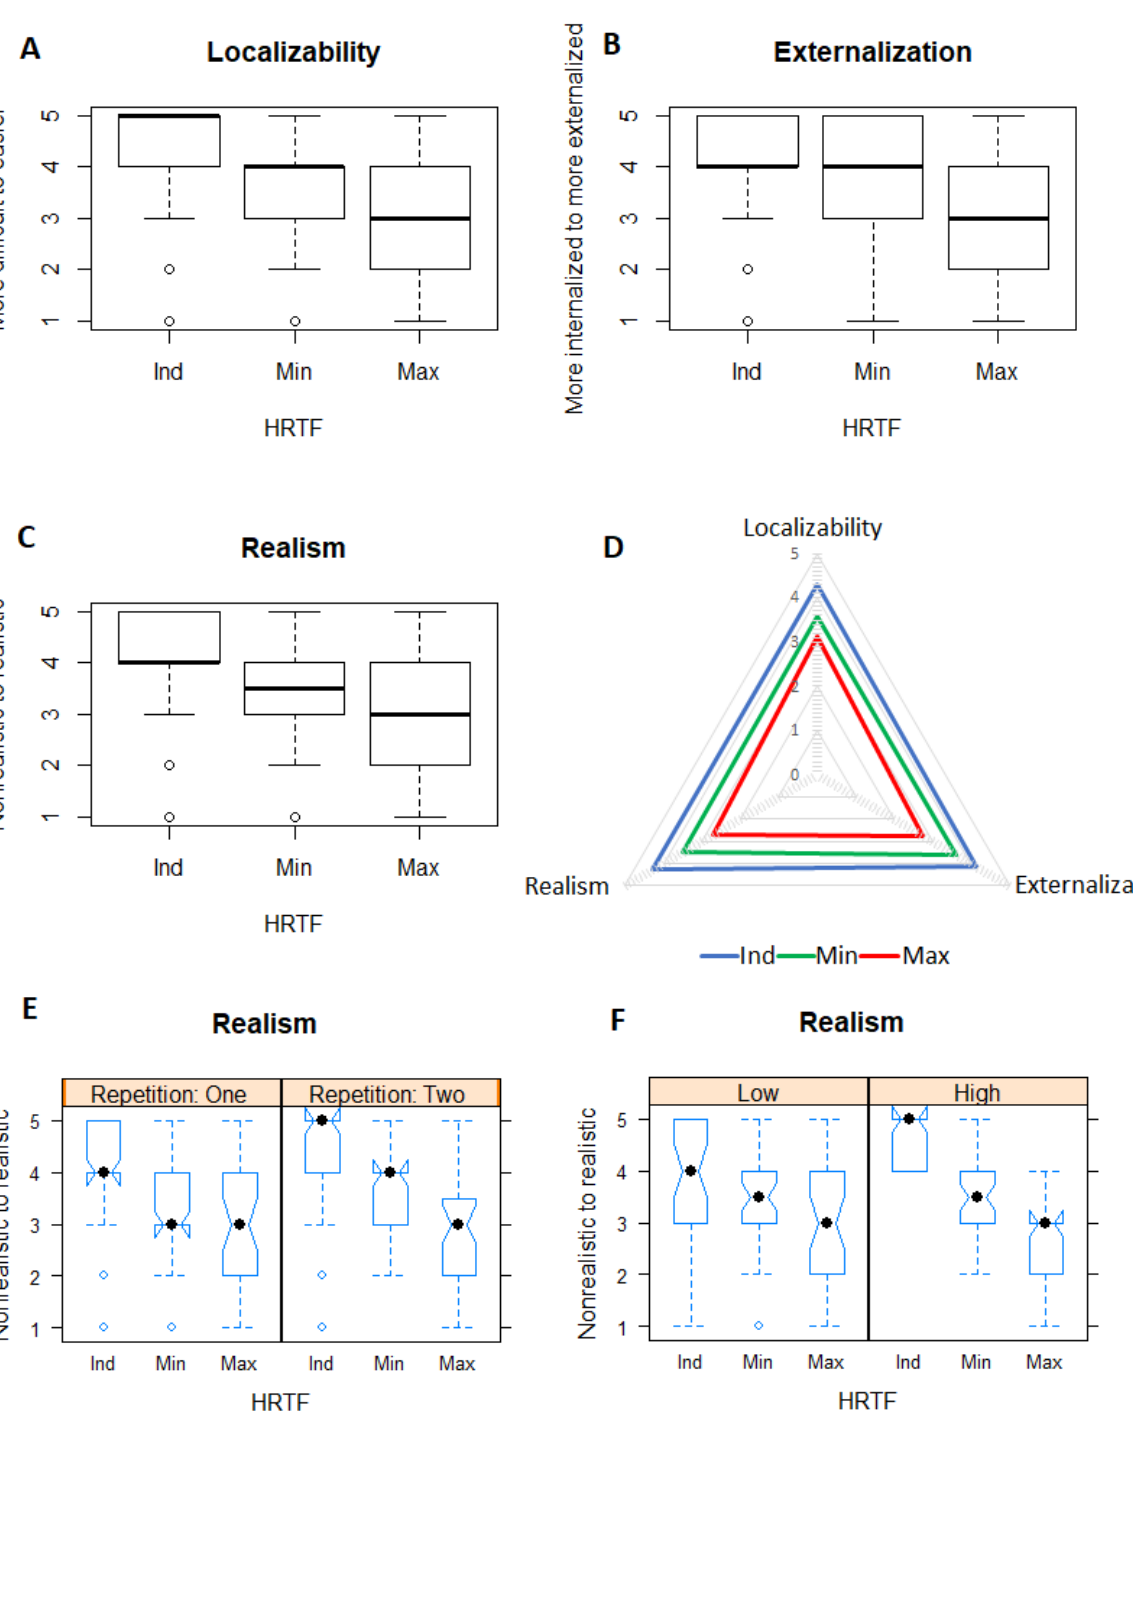
Figure 5. Result of the second test (individual vs minimal vs maximal). A: Localizability overall box plot; B: Externalization overall box plot; C: Realism overall box plot; D: Radar chart for localizability, externalization, and realism; E: Repetition response behavior; F: Expertise response behavior. Ind: individual HRTF; Min: minimal; Max: maximal; HRTF: head-related transfer